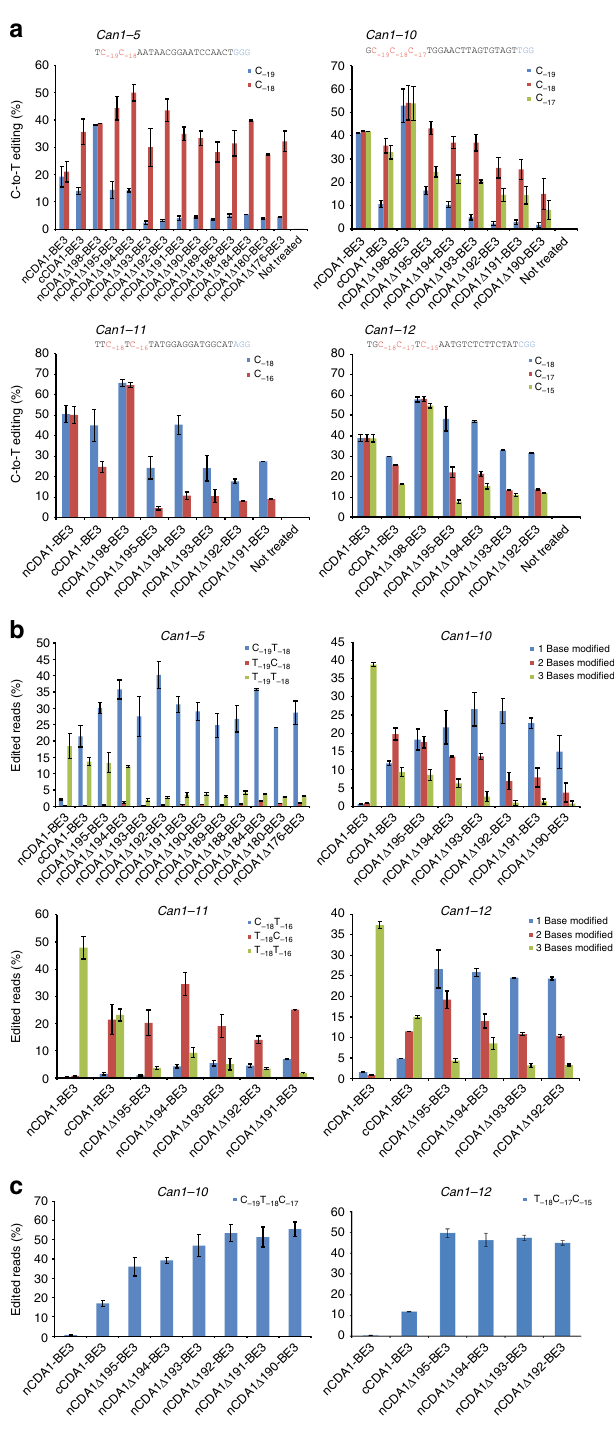
Fig. 5 Base editors with C-terminally truncated CDA1 domains edit position C − 18 with high precision. nCDA1-BE3, cCDA1-BE3, and selected base editors with C-terminally truncated CDA1 domains are compared. a Editing of genomic loci containing multiple cytidines directly adjacent or in close proximity to C − 18 . Cytidines representing possible editing targets are shown in red with the subscript number representing their position relative to the PAM (blue). b , c Base editors with truncated CDA1 domains greatly improve editing product distribution and produce predominantly singly C − 18 -modi fi ed products. % of edited reads represents the percentage of total sequencing reads containing the products shown. Values and error bars represent the mean and standard deviation of three biological replicates. Source data are provided as a Source Data fi